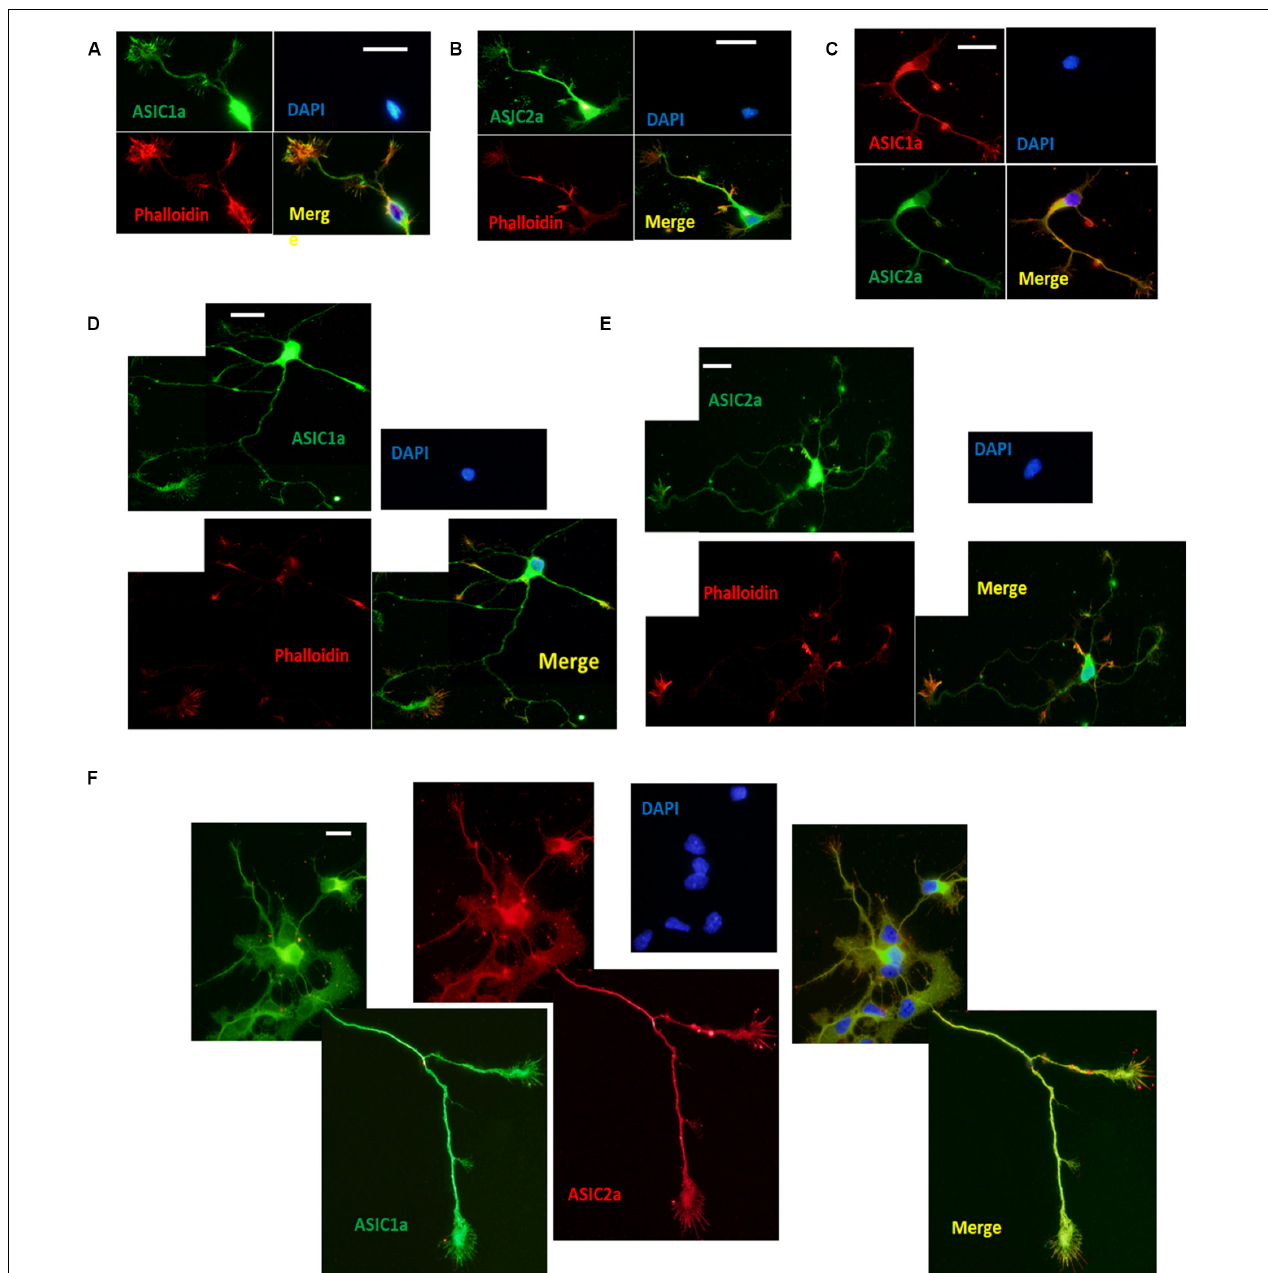
FIGURE 1 | Endogenous ASIC1a and ASIC2a are expressed in growth cones of DIV3-DIV6 hippocampal neurons. (A,B) DIV3 primary hippocampal cultures were coimmunostained for ASIC1a and phalloidin, ASIC2a and phalloidin, respectively. ASIC1a and ASIC2a display the distribution throughout the cell and are present at axonal growth cones. (C) Distribution of ASIC1a and ASIC2a is almost the same at DIV3 primary hippocampal neurons. (D,E) DIV6 primary hippocampal cultures were coimmunostained for ASIC1a and phalloidin, ASIC2a and phalloidin, respectively. (F) Distribution of ASIC1a and ASIC2a is almost the same at DIV6 primary hippocampal neurons. Scale bars, 20 µ